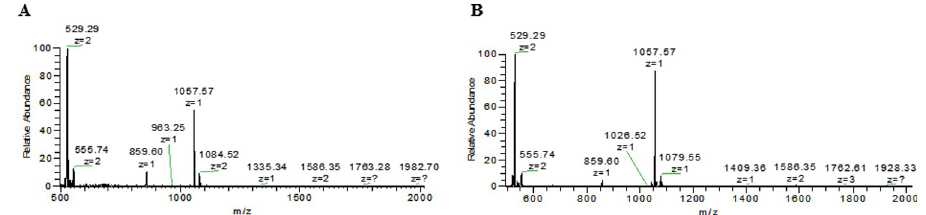
Fig 3. Mass spectra for purified antifungal compounds produced by Bacillus velezensis WRB-ZX-001 and WRB-ZX-002. A and B are LC-MS spectra for HPLC collected active fraction of WRB-ZX-001 and WRB-ZX-002. Ion with m/z value of 1057.57 was assigned to C 15 iturin A [M+H] + . Ion with m/z value of 1079.55 was assigned to C 15 iturin A [M+Na] +